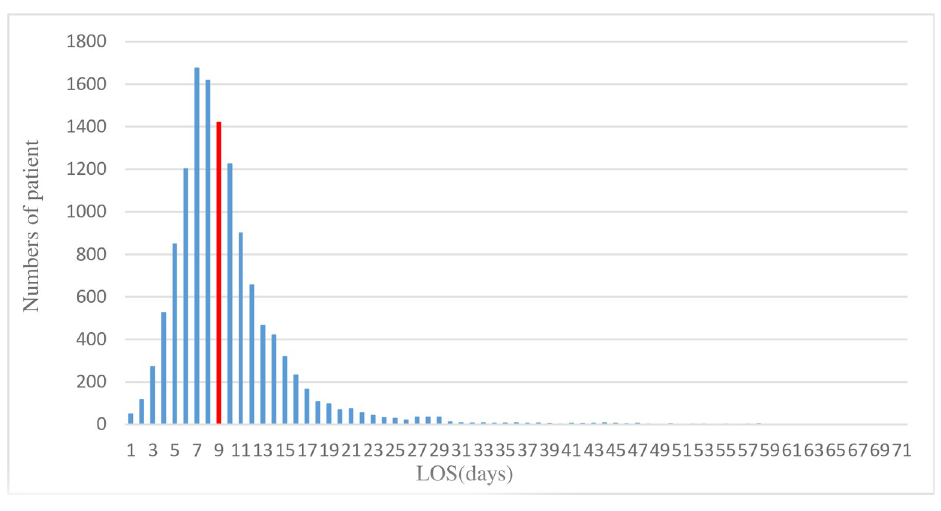
Fig 1. Numbers of patients by LOS.